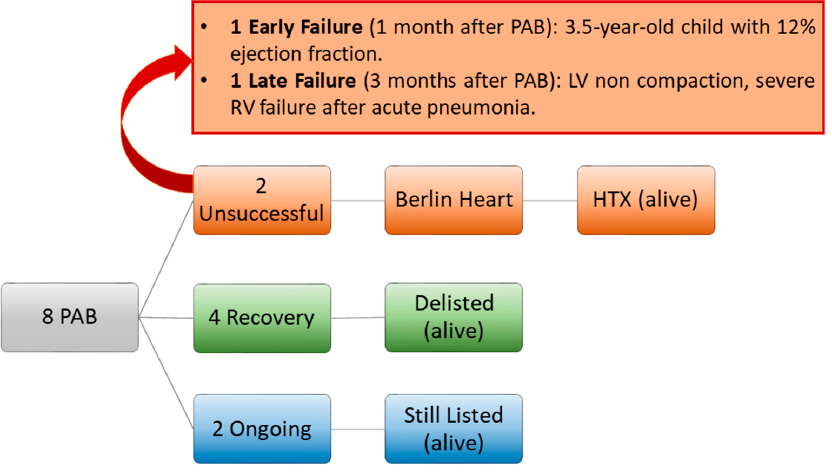
Figure 1. Padova experience with PAB for LV rehabilitation in DCM since 2015. HTX: heart trans- plantation. PAB: pulmonary artery banding. RV: right ventricle. plantation. PAB: pulmonary artery banding. RV: right